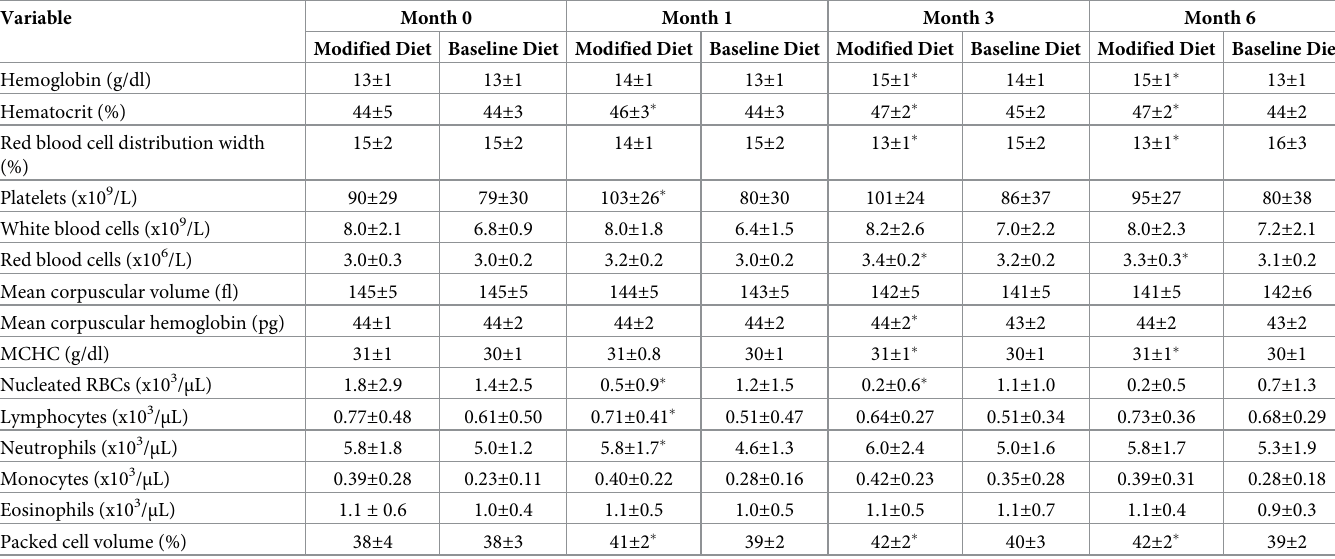
Table 3. Comparisons of red and white blood cell index values in bottlenose dolphins ( Tursiops truncatus ) fed a modified versus baseline diet over 6 months.